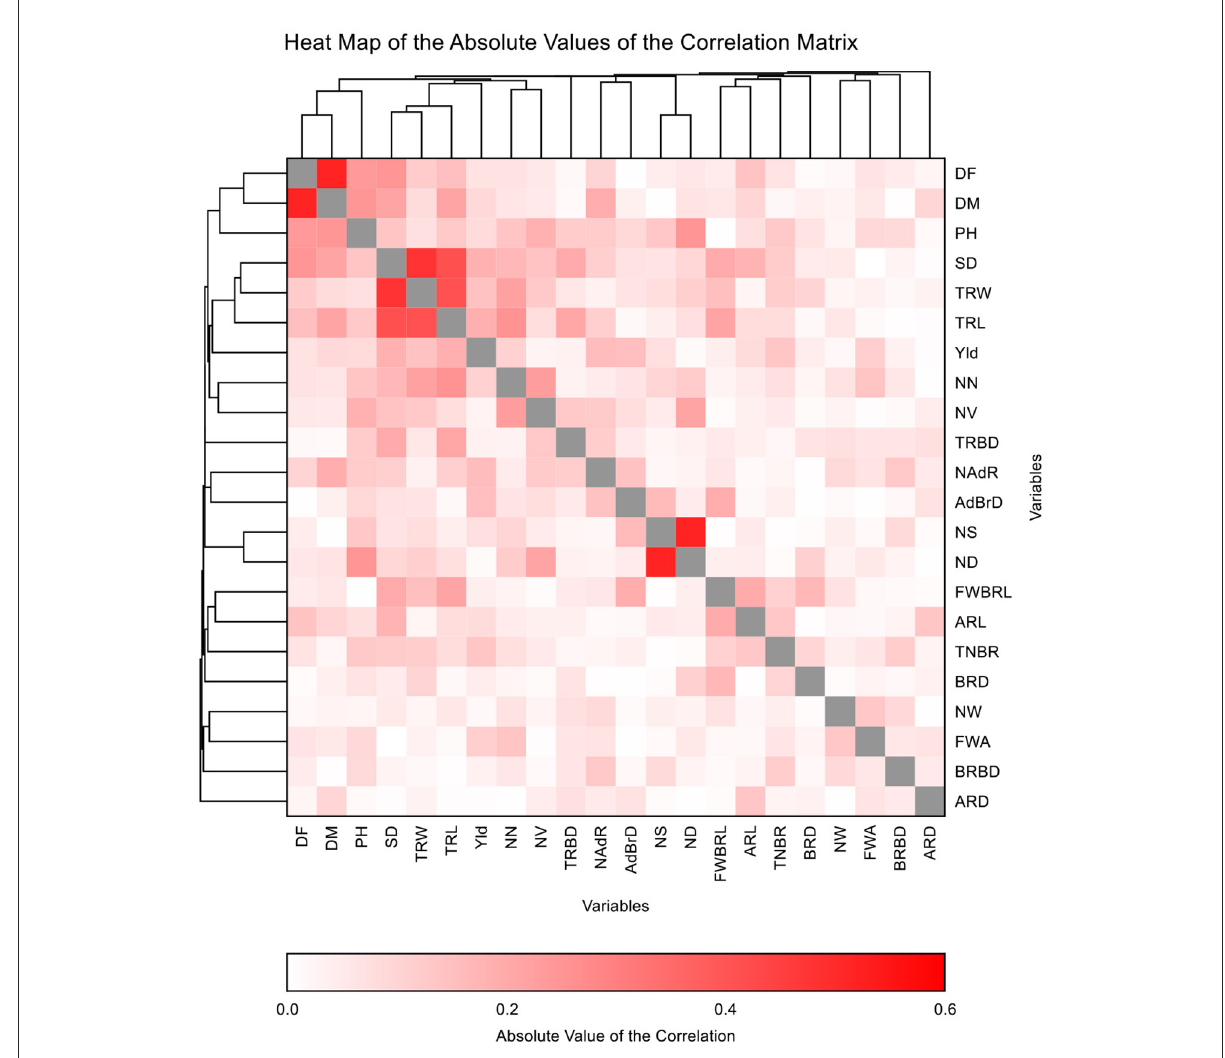
FIGURE3 Heat map demonstrating phenotypic correlations among grain yield root morphometric and architecture of cowpea genotypes.